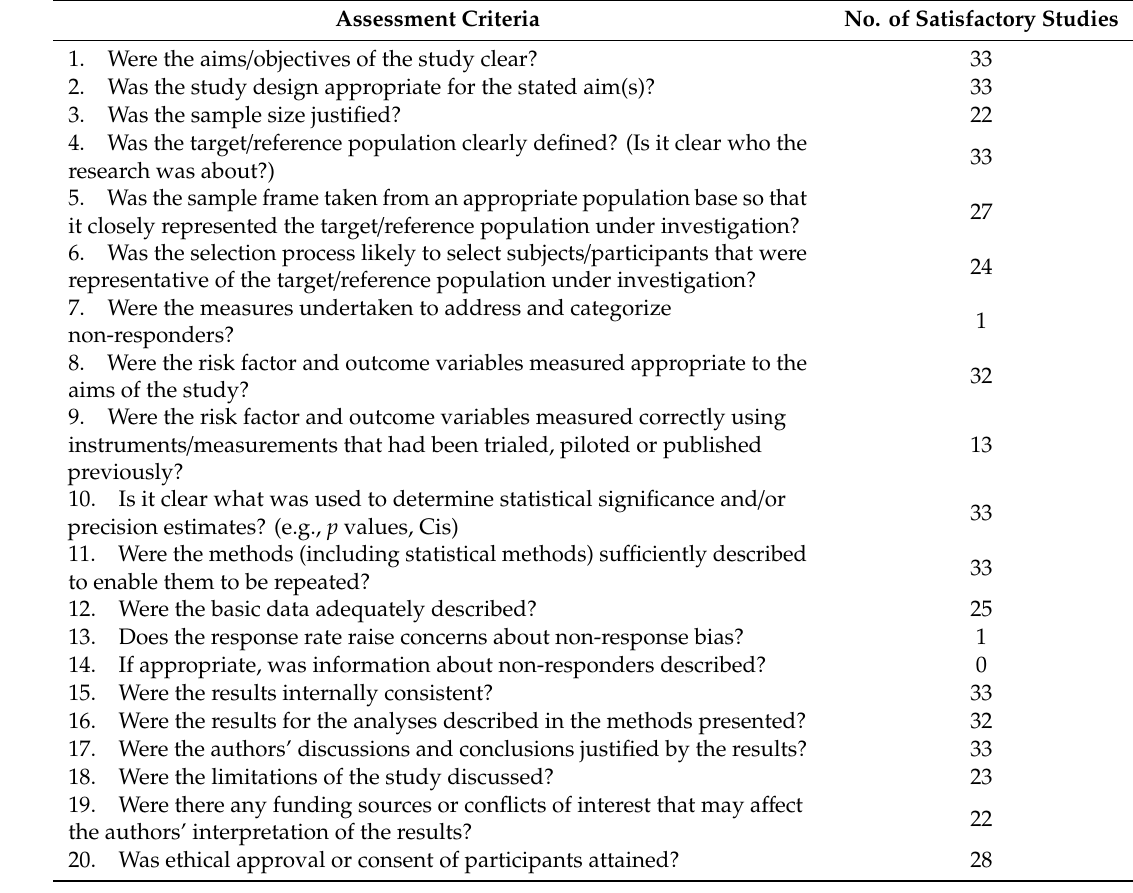
Table 2. Appraisal Tool for Cross-Sectional Studies